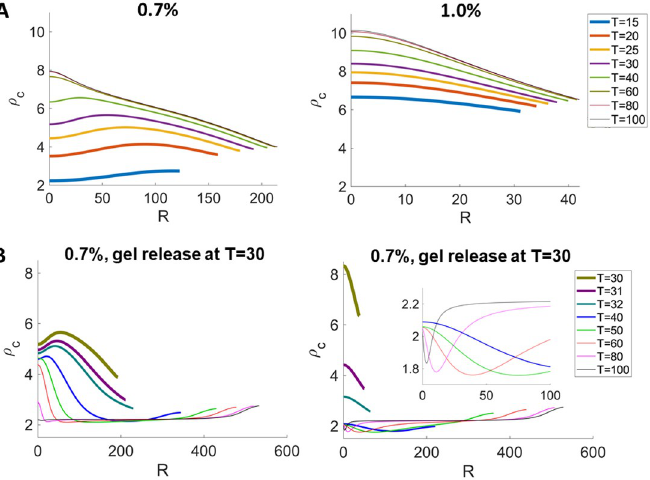
Fig 3. Cell densities ρ in the constrained tumor in Fig 2. (A) The regions with largest cell density shifts towards the c tumor center, indicating cells are more packed inside the tumor. (B) After releasing the gel, the cell density recovers to the same level in the unconstrained tumor. See S3 Text for the list of